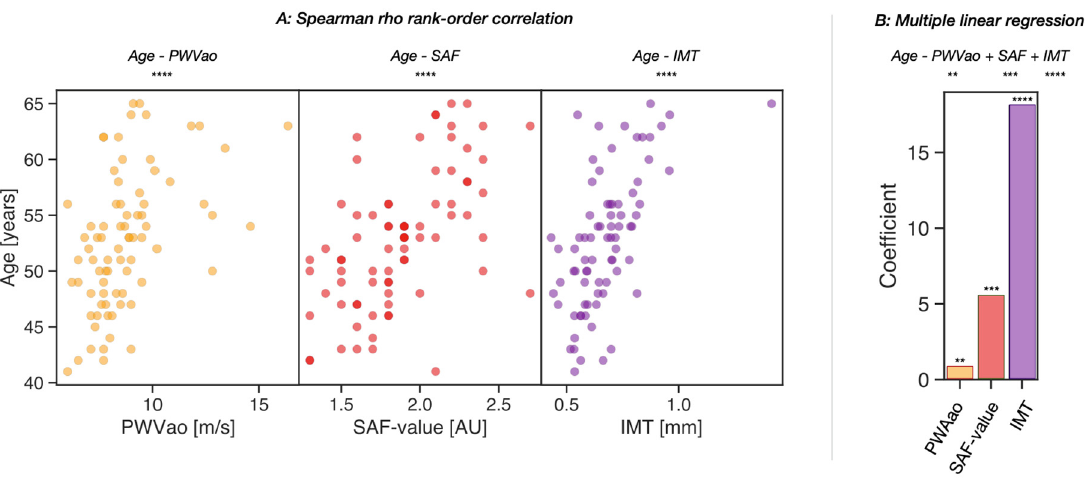
Figure 2. Association between age and the parameters of vascular function, PWVao (yellow), skin SAF value (red), and IMT (purple), in the subgroup of participants with all three measurements ( n = 77). ( A ) Spearman ʹ s correlations between age and the three variables are depicted in the sca tt er plot. ( B ) The bar plot reveals the contributions of the three independent variables PWVao, skin SAF value, and IMT, with the dependent variable, age, in a multiple linear regression model. Signi fi - cances are given as **: 1.00 × 10 − 3 < p ≤ 1.00 × 10 − 2 ; ***: 1.00 × 10 − 4 < p ≤ 1.00 × 10 − 3 ; and ****: p ≤ 1.00 × 10 − 4 .